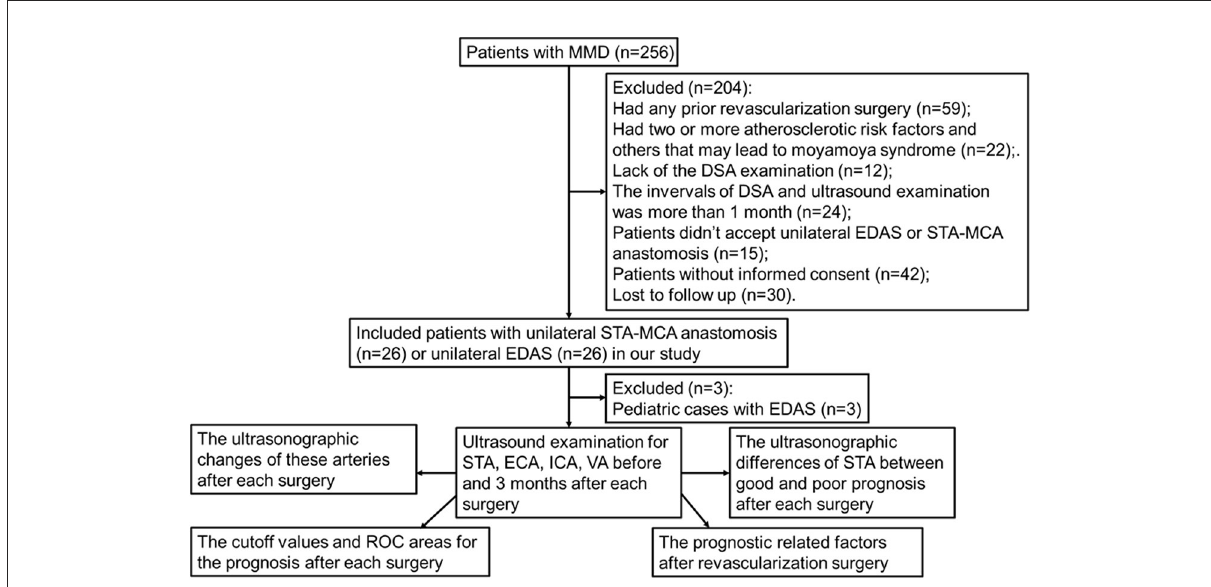
FIGURE1 Schematic diagram of patient selection and exclusion. MMD, indicates moyamoya disease; DSA, digital subtraction angiography; EDAS, encephalo-duro-arterio-synangiosis; STA, superficial temporal artery; MCA, middle cerebral artery; ECA, external carotid artery; ICA, internal carotid artery; VA, vertebral